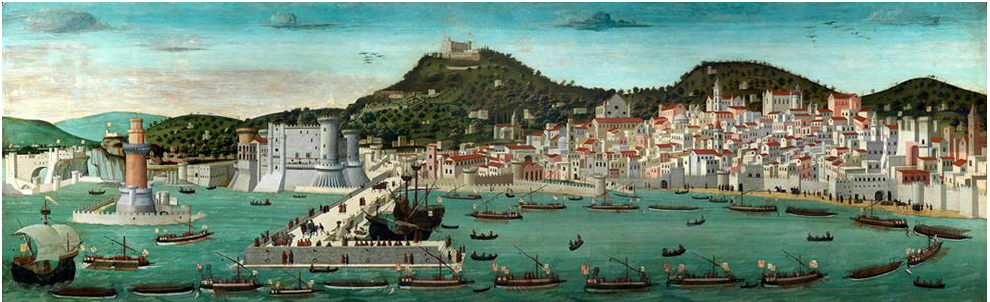
Figure 3. Tavola Strozzi: view of Naples depicting the Aragonese fleet re-entering the port on 12 July 1465 after the defeat of the Angevin Navy at Ischia on 7 July. (Attributed to F. Rosselli—Museo Nazionale di San Martino, Naples, Italy.)